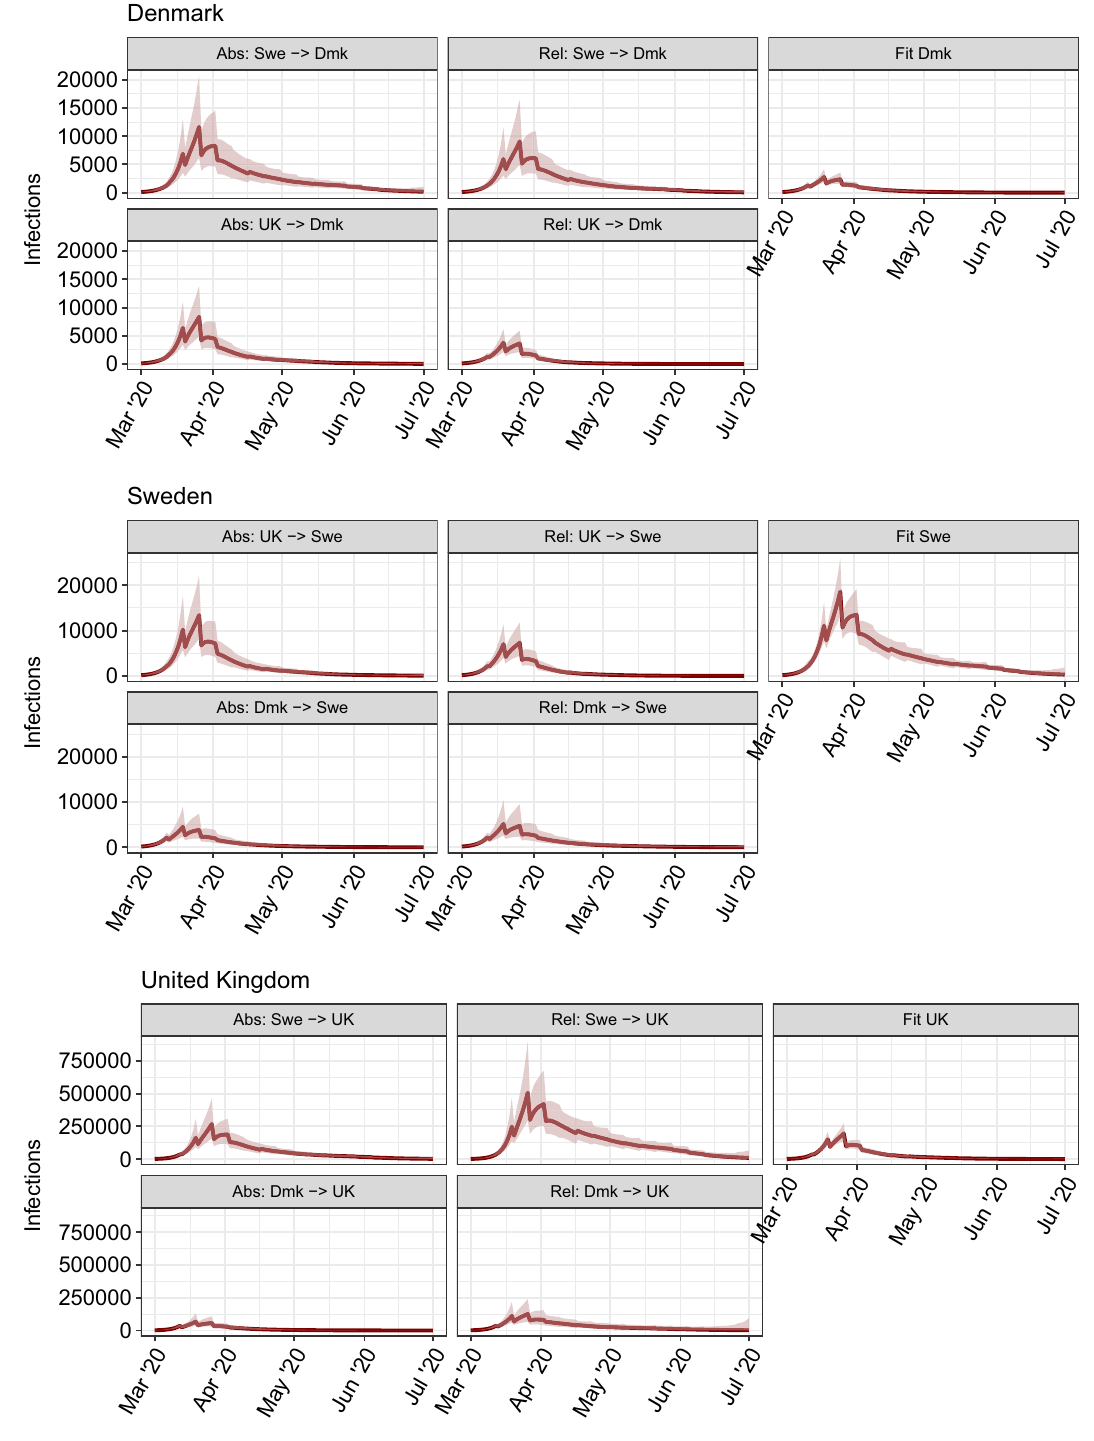
Figure 3. Median daily infection incidence with 95% credible interval for Denmark (top block), Sweden (middle block) and the UK (lower block). Left column shows results for the absolute R t transposition approach, middle column for the relative R t / R 0 transposition approach, and right column shows the fit to observed data (i.e. without counterfactual swapping). Plots show y-axis on the same scale to highlight differences between